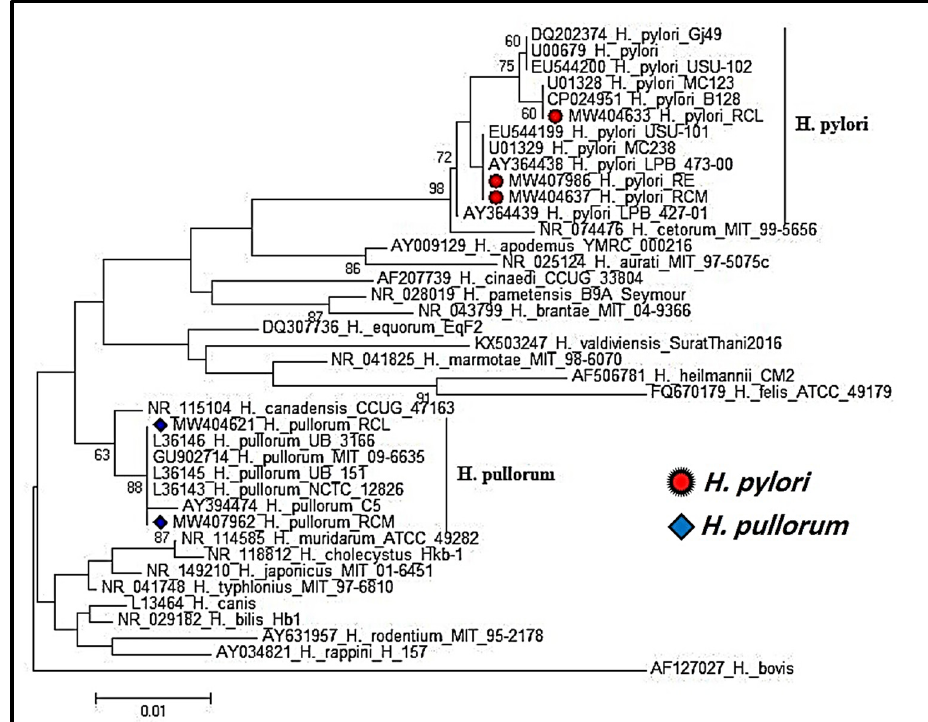
Figure 4. Phylogeny analysis of the 16S rRNA sequences of the isolated three H . pylori (a red circular shape) and the two H . pullorum (a blue rhombus shape) isolates.